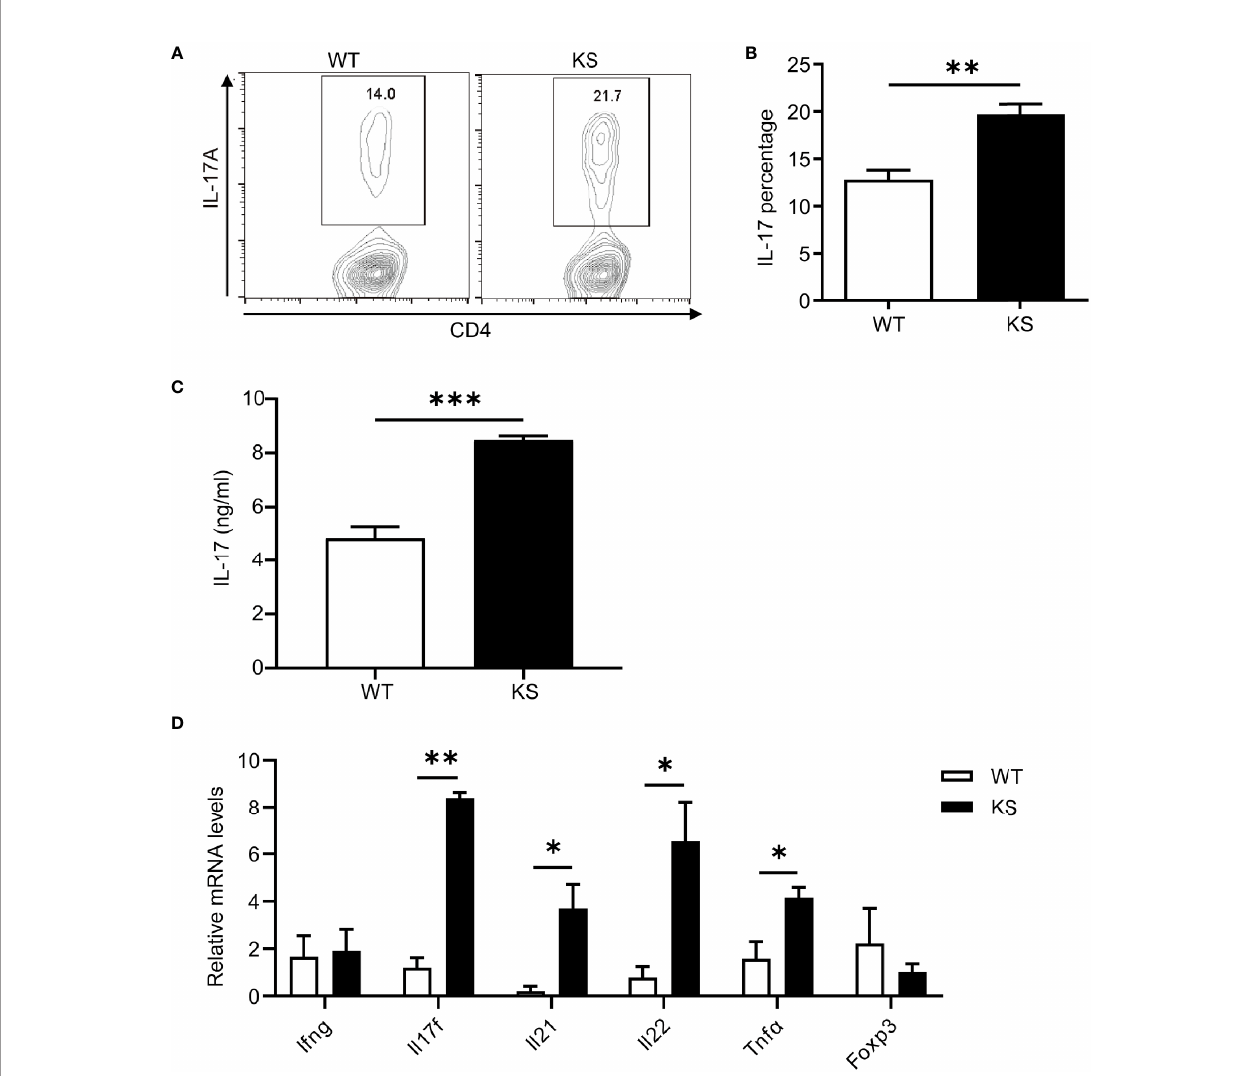
FIGURE 7 | Kallistatin favors differentiation of CD4 + naïve T cells to effector Th17 cells. Naïve CD4 + T cells puri fi ed from spleen and dLNs in WT and KS mice and cultured under Th17 polarizing conditions. (A) On day 5 of differentiation, the cells were then stimulated with PMA, ionomycin and brefeldin for 5 h, followed by fl ow cytometry analysis. (B) Bar diagram is shown for IL-17A + frequencies in CD4 + T cells of WT and KS mice. (C) The supernatants harvested at 48 h of culture were assessed for IL-17A by ELISA. (D) Cells collected after 48h culture were determined for the mRNA expression of indicated cytokines by real-time qPCR analysis. Data are representative of three individual experiments and graphs are shown as mean values ± SEM. n = 3, *p < 0.05, **p < 0.01, ***P < 0.001. (Unpaired Student ’ s t